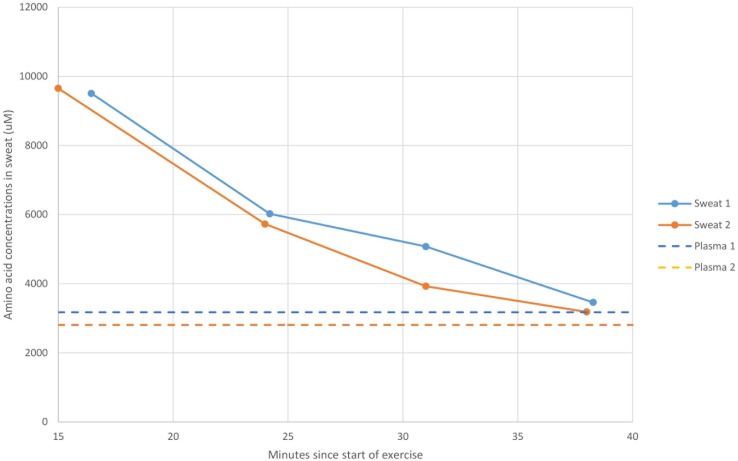
Total amino acid levels (μM) in sweat measured for two athletes completing a 40 minute self-paced cycle under controlled conditions compared against fasted plasma levels previously recorded for each of the athletes over a 6 week period.